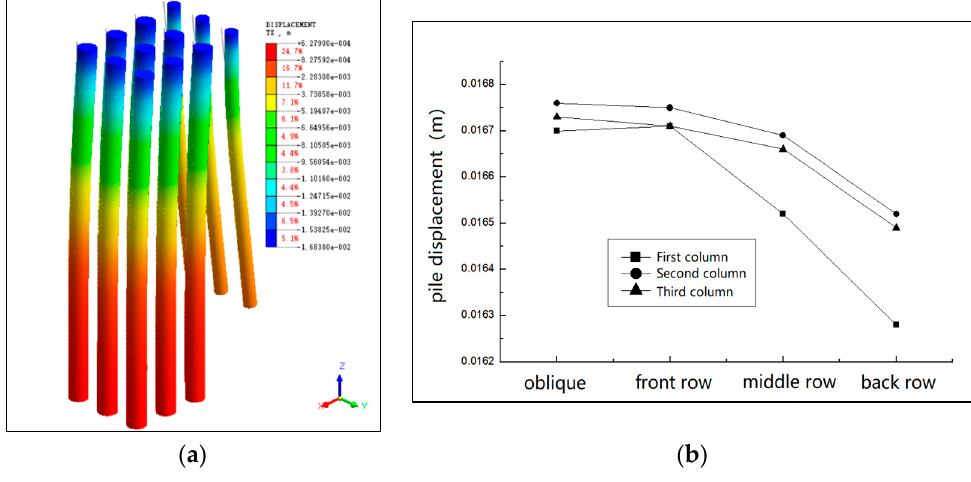
10 of 17 Figure 10. Axial diagram of JinDao bridge.